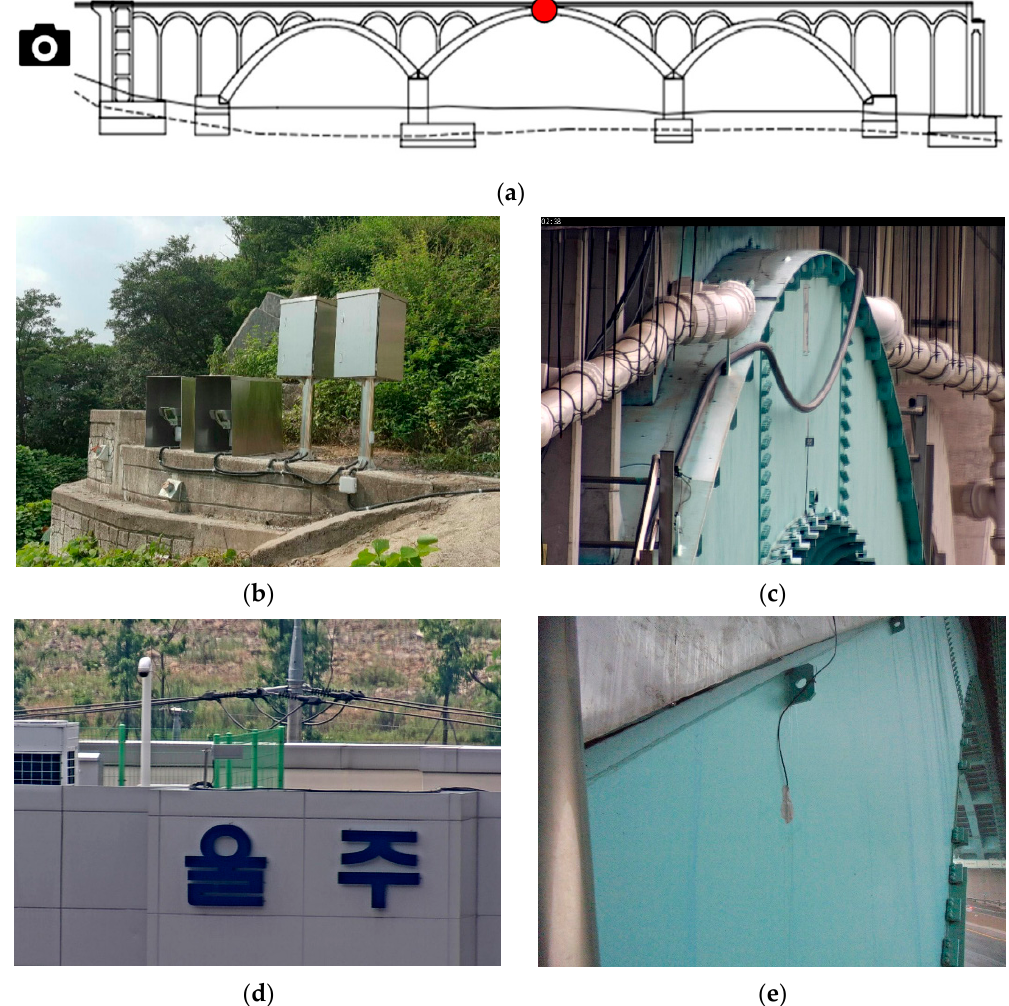
Figure 3. ( a ) Measurement location; ( b ) two video cameras; ( c ) bridge target video camera view